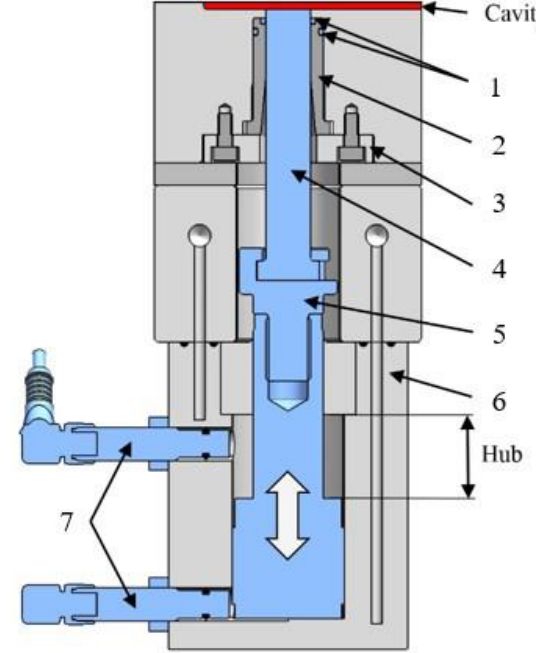
Figure 9. Ejector system (1—sealing; 2—guide bush; 3—fixing plate; 4—ejector pin; 5—coupling; 6—hydraulic cylinder; 7—position sensor).